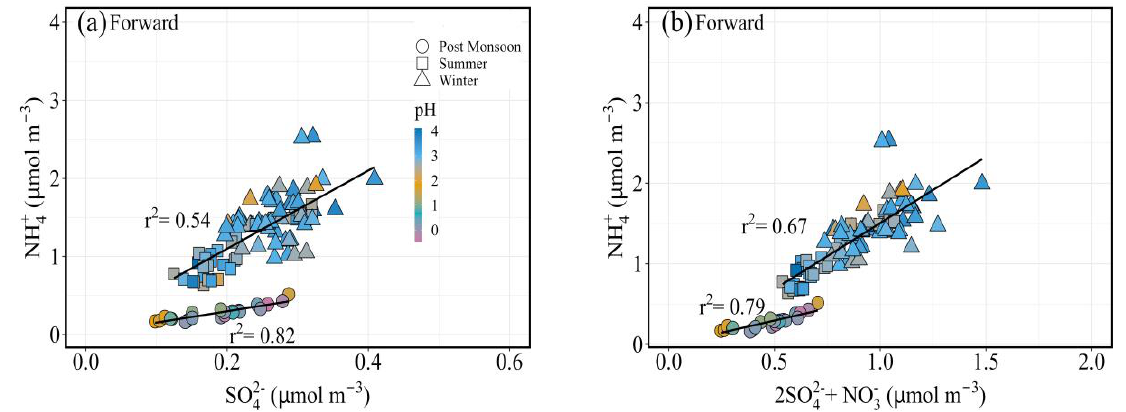
Figure 7. Ammonium concentration as a function of sulfate ( a ) and the sum of sulfate and nitrate ( b ) concentration of PM 2.5 samples.